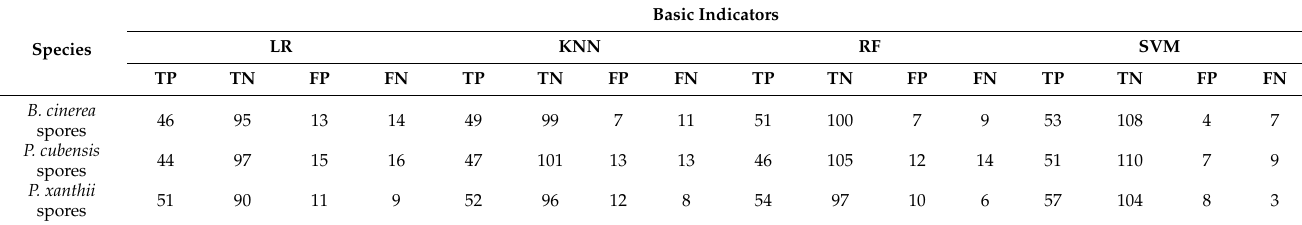
Table 2. Classification results of different classification models.